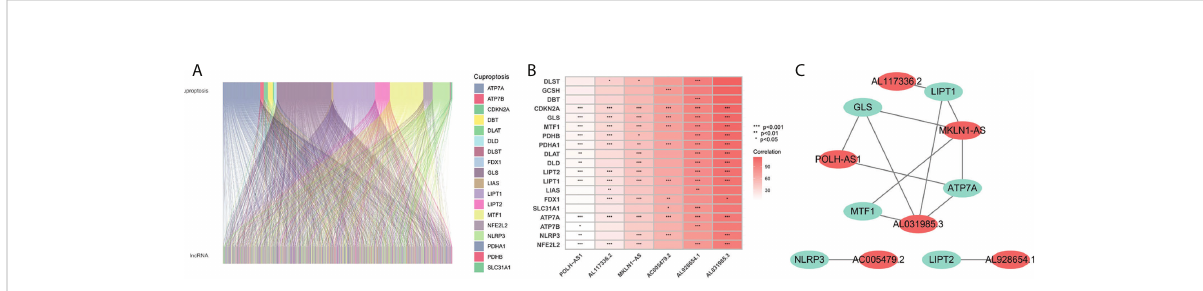
FIGURE 2 Screening of prognosis-related genes. (A) Sankey diagram of the associations between between cuproptosis-related lncRNAs and mRNAs. (B) The correlation heatmap of 6 screened lncRNAs and cuproptosis-related genes. (C) The network diagram of 6 screened lncRNAs and cuproptosis-related